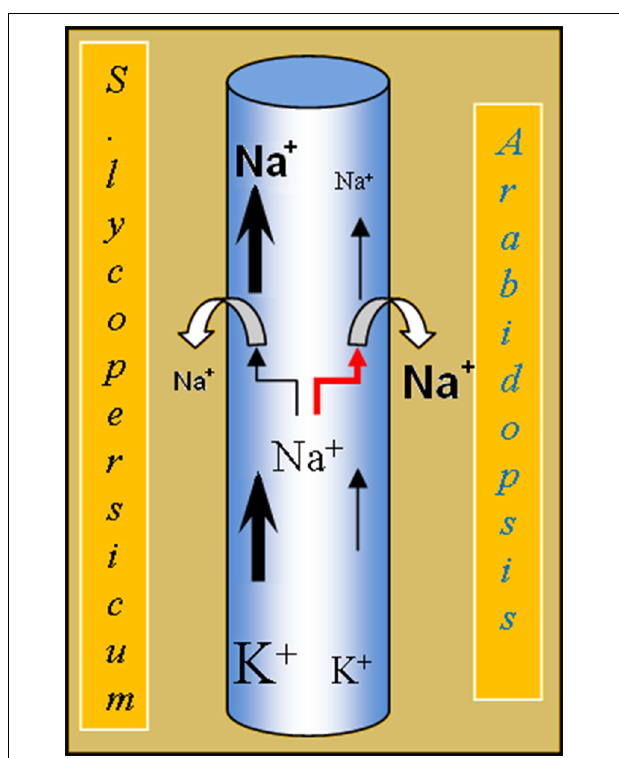
FIGURE 6 | Model depicting the difference in K + -sensitivity of SlHKT1;2 from S. esculentum and AtHKT1;1 from Arabidopsis . When the K + -concentration in the xylem sap is high, Na + -uptake by the SlHKT1;2 transporter is reduced. As a result the amount of Na + in the xylem stream reaching the shoot of tomato is, at least partially, controlled by SlHKT1;2, which in turn depends on the concentration of K + present in the xylem sap. In Arabidopsis , Na + -uptake in the XPCs by the AtHKT1;1 transporter is not affected by high K +